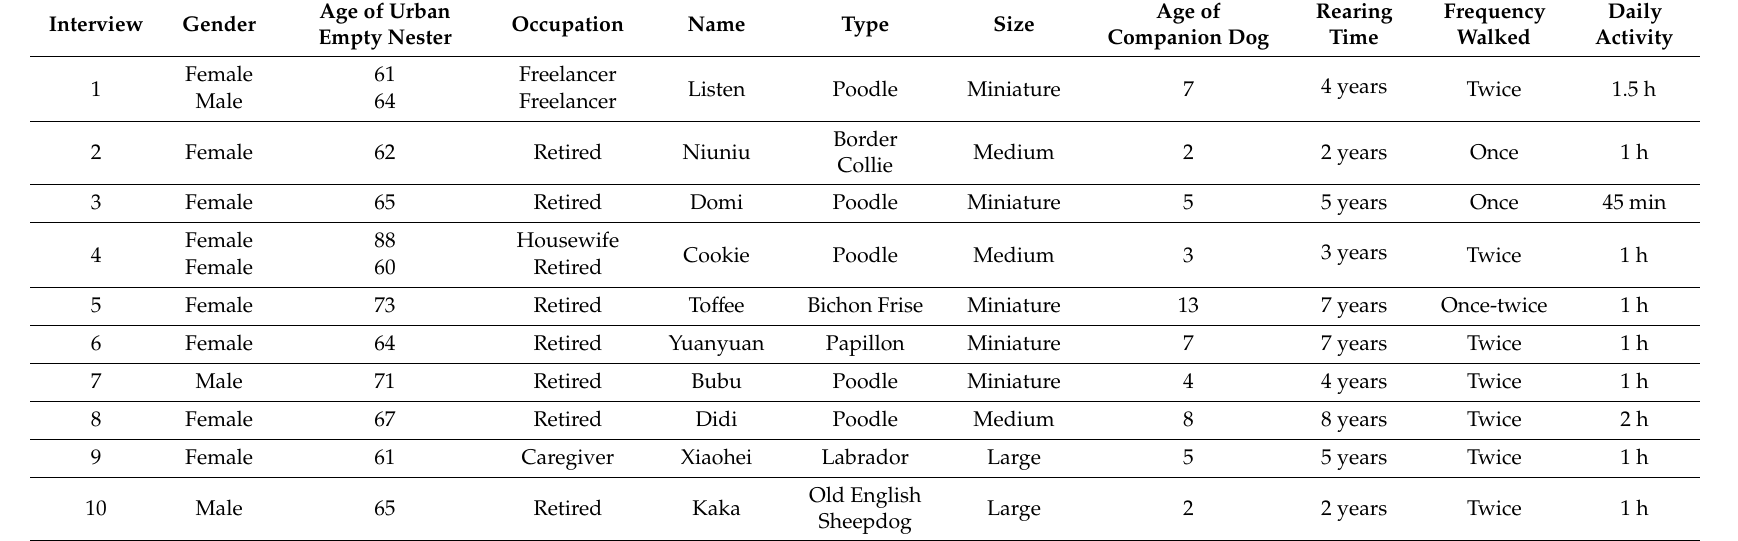
Table 1. Interview information on the urban empty nesters and their companion